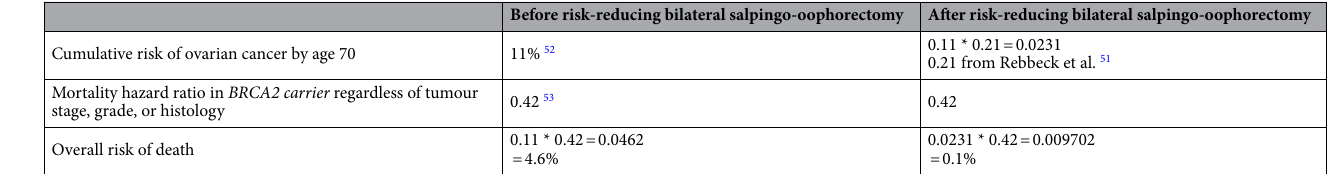
Before risk-reducing bilateral salpingo-oophorectomy After risk-reducing bilateral